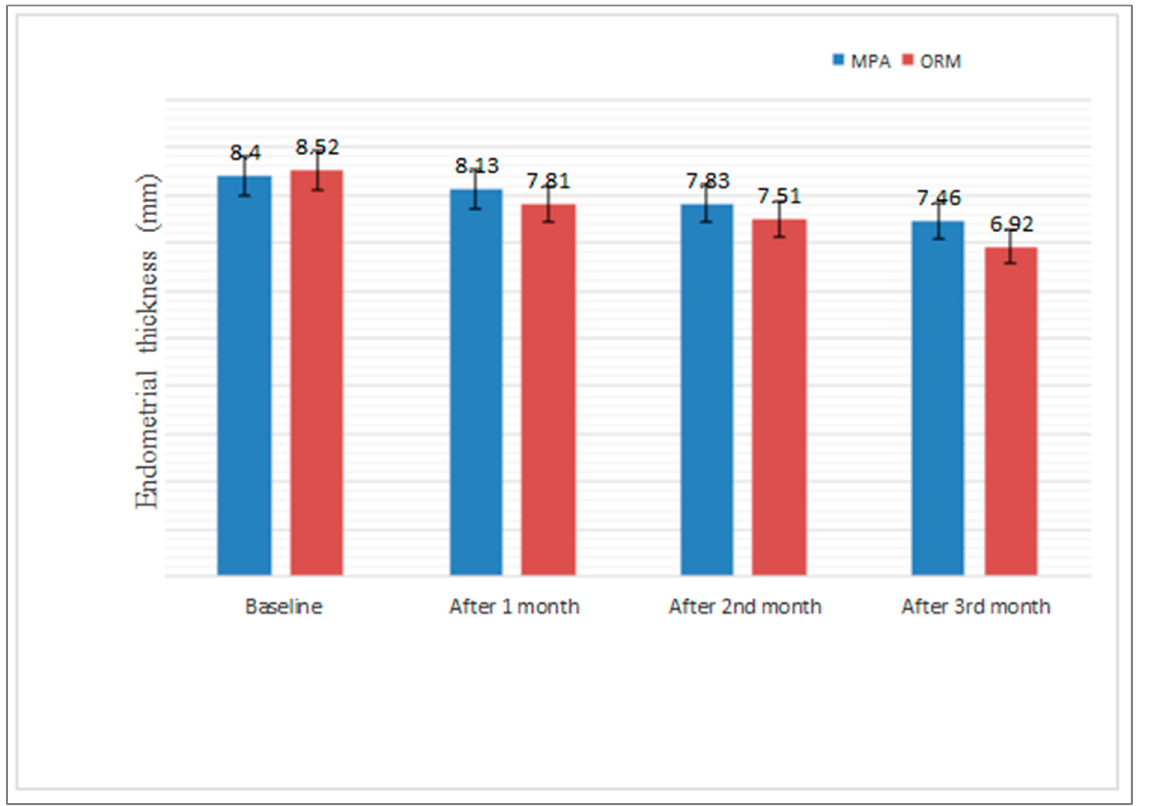
nificance. significance.